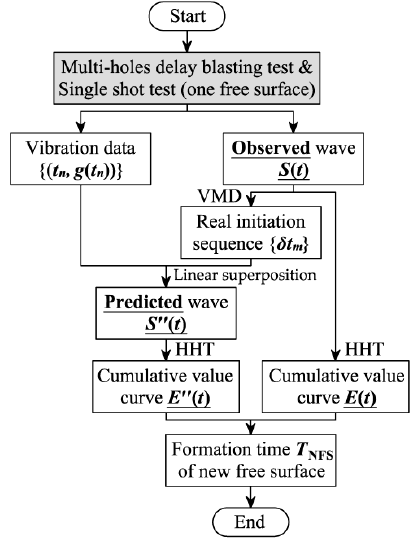
Figure 2. Identification flow.